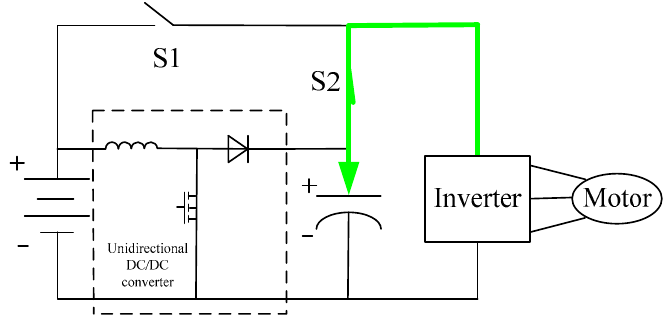
Figure 9. Mode 6—the SC harvests the braking energy solely.